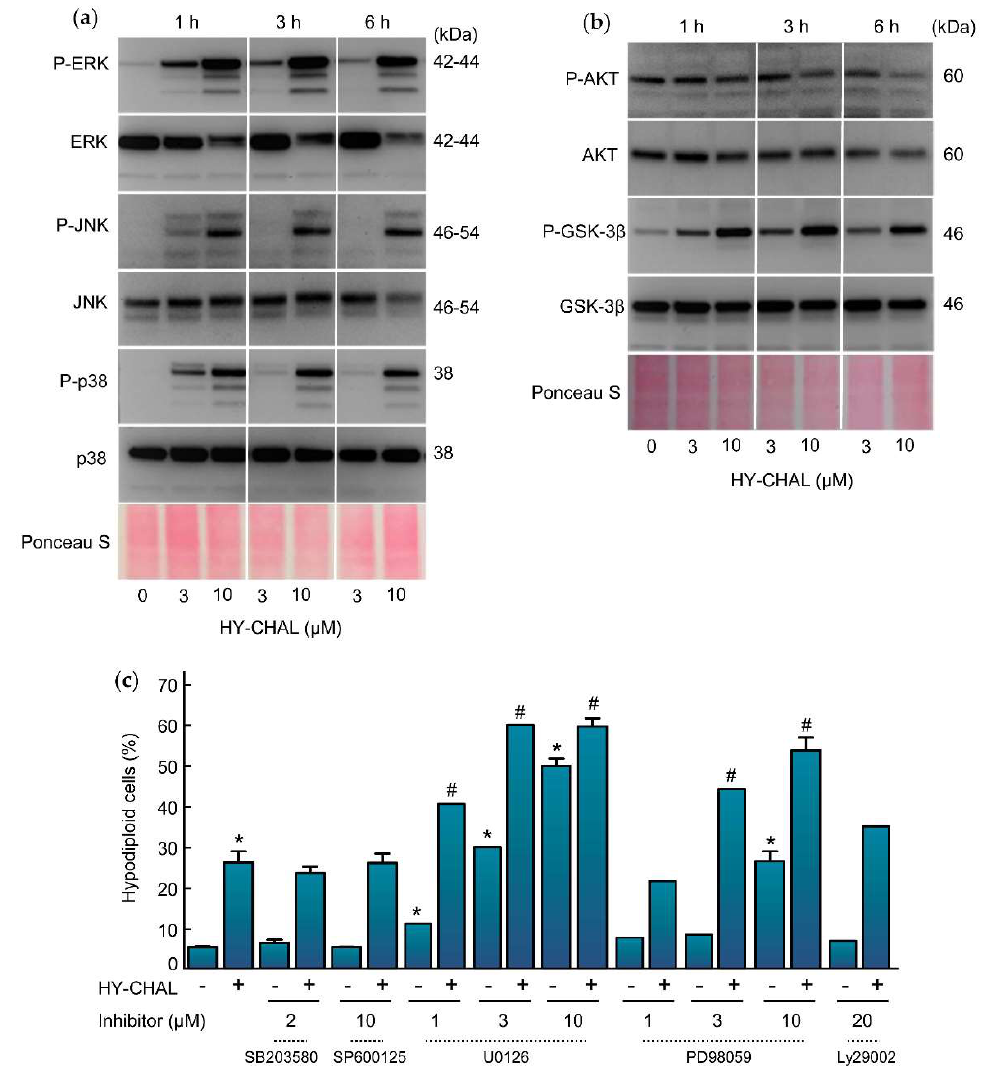
Figure 5. Effect of HY-CHAL on MAPK and AKT pathways. ( a ) Time-dependent phosphorylation of ERK1/2, JNK/SAPK and p38 MAPK and ( b ) of AKT and GSK-3 β by HY-CHAL. Cells were incubated with the concentrations specified for the time periods shown. Lysates were analyzed on Western blots probed with specific antibodies to ascertain the phosphorylation of MAPKs, AKT, and GSK-3 β . Membranes were stripped and reprobed with specified antibodies as loading controls. Equal protein loading was also controlled by staining the membrane with Ponceau S; ( c ) Effect of MAPKs and PI3K inhibitors on HY-CHAL-induced cell death. Cells were preincubated with the p38 MAPK inhibitor SB203580 (2 µ M), the JNK/SAPK inhibitor SP600125 (10 µ M), the indicated concentrations of the MEK1/2 inhibitors U0126 and PD98059 or the PI3K inhibitor LY294002 (20 µ M) and then treated with 3 µ M HY-CHAL for 24 h. The percentages of hypodiploid cells were determined by flow cytometry after propidium iodide staining. Bars represent means ± SEs of two independent experiments performed in triplicate. * Indicates p < 0.05 for comparison with untreated control. # Indicates p < 0.05 for comparison with HY-CHAL treatment alone.